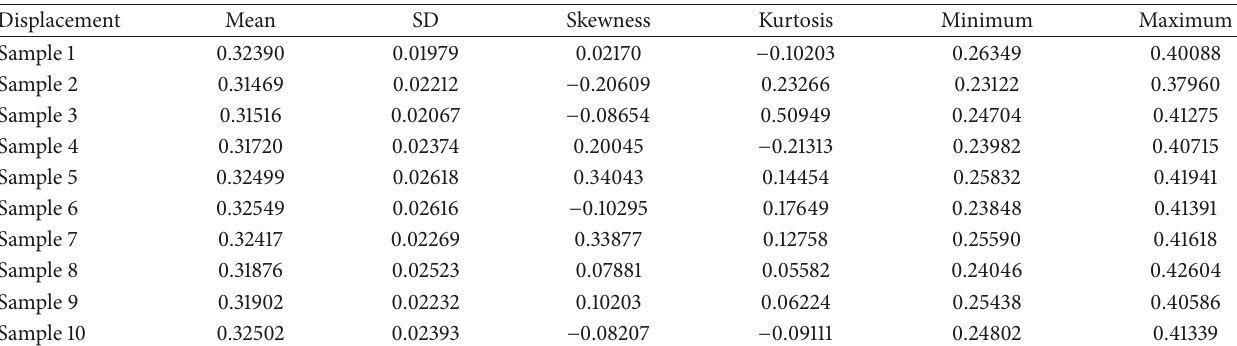
Table 16: Statistics of 10 samples parameters of high tower in the system top node 35# Ux displacement time history under wind field 2